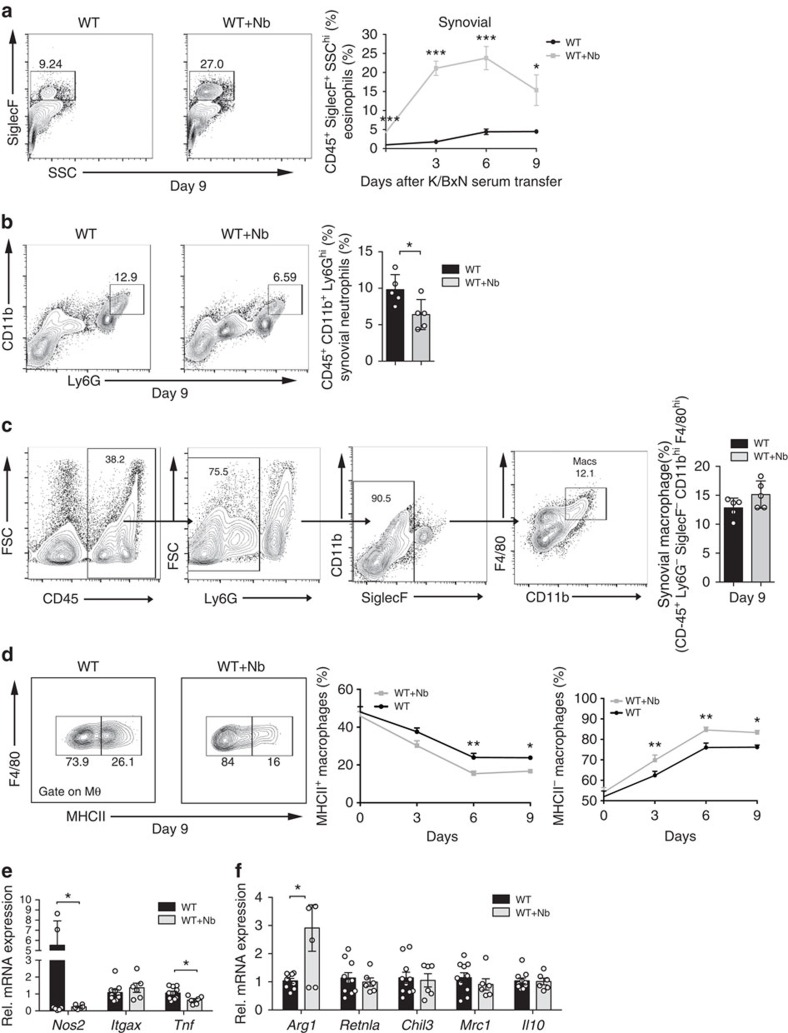
N. brasiliensis infection increases eosinophil and anti-inflammatory macrophage numbers in the joints.(a) Representative contour plots and eosinophil (CD45+SiglecF+) quantification in the ankle joint of WT mice with or without N. brasiliensis (Nb) challenge at day 9 post serum transfer (n=5 per group). Numbers represent percentage in CD45+ cells. Frequency of eosinophils in the joints of WT mice with or without Nb challenge at the indicated time points (n=5 per group). (b) Representative contour plots and percentage of neutrophil (CD45+CD11b+Ly6Ghi) in the joints of WT mice with or without Nb challenge at day 9 post serum transfer (n=5 per group). (c) Gating strategy for the identification of macrophages in the joints of WT mice. Percentage of total macrophages (defined as CD45+Ly6G−SiglecF−CD11bhiF4/80hi cells) in WT mice with or without Nb challenge 9 day post serum transfer (n=5 per group). Numbers represent percentage of the parent population. (d) Frequency of pro (MHC II+) and anti-inflammatory (MHC II−) macrophages in the joints of WT mice with or without Nb challenge at the indicated time points (n=15 per group). (e,f) Quantitative reverse transcriptase–PCR (RT–PCR) analyses of (e) Nos2 (encoding inducible nitric oxide synthase), Itgax (encoding CD11c) and Tnf, as well as (f) Arg1 (encoding arginase-1), Retnla (encoding resistin-like alpha), Chil3 (encoding chitinase-like protein 3), Mrc1 (encoding macrophage mannose receptor 1) and Il10 expression in synovial extracts from WT mice with or without Nb challenge (n=6–10 per group). Data are shown as mean±s.e.m. Pictures are representative of 3 independent experiments, except for (d) where the data were pooled from three independent repeats. Asterisks mark statistically significant difference (*P<0.05, **P<0.01 and ***P<0.001, determined by Student's t-test).